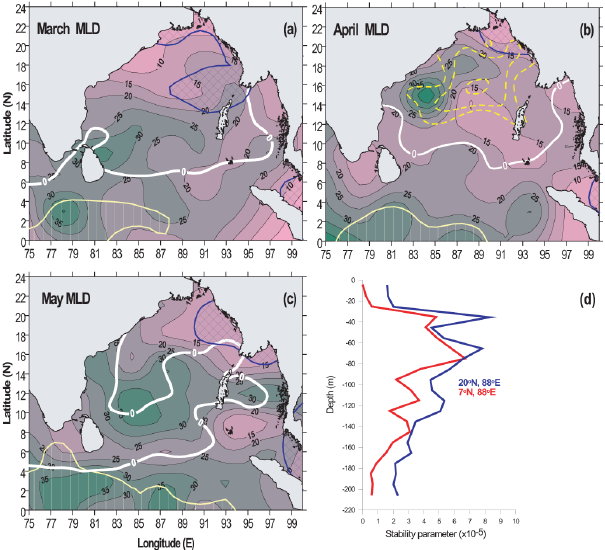
Figure 4. Monthly mean climatology of mixed layer depth (m) in the Bay of Bengal during spring intermonsoon in (a) March, (b) April and (c) May, and (d) vertical profiles of the upper ocean stabil- ity parameter ( E , m − 1 ) at 20 ◦ N, 88 ◦ E (blue line) and 7 ◦ N, 88 ◦ E (red line) in April. In (a–c) the blue crosshatch represents the re- gion where salinity is less than 32psu, while vertical lines within the thin yellow solid line represent the region where the salinity is greater than 34.5psu. The thick broad white line indicates the zero wind stress curl and the region south of it (equatorward) have pos- itive wind stress curl. The yellow broken contours in (b) indicate the negative wind stress curl ( − 10 to − 20 × 10 − 8 Pam − 1 ) with in- creasing magnitude towards the centre.